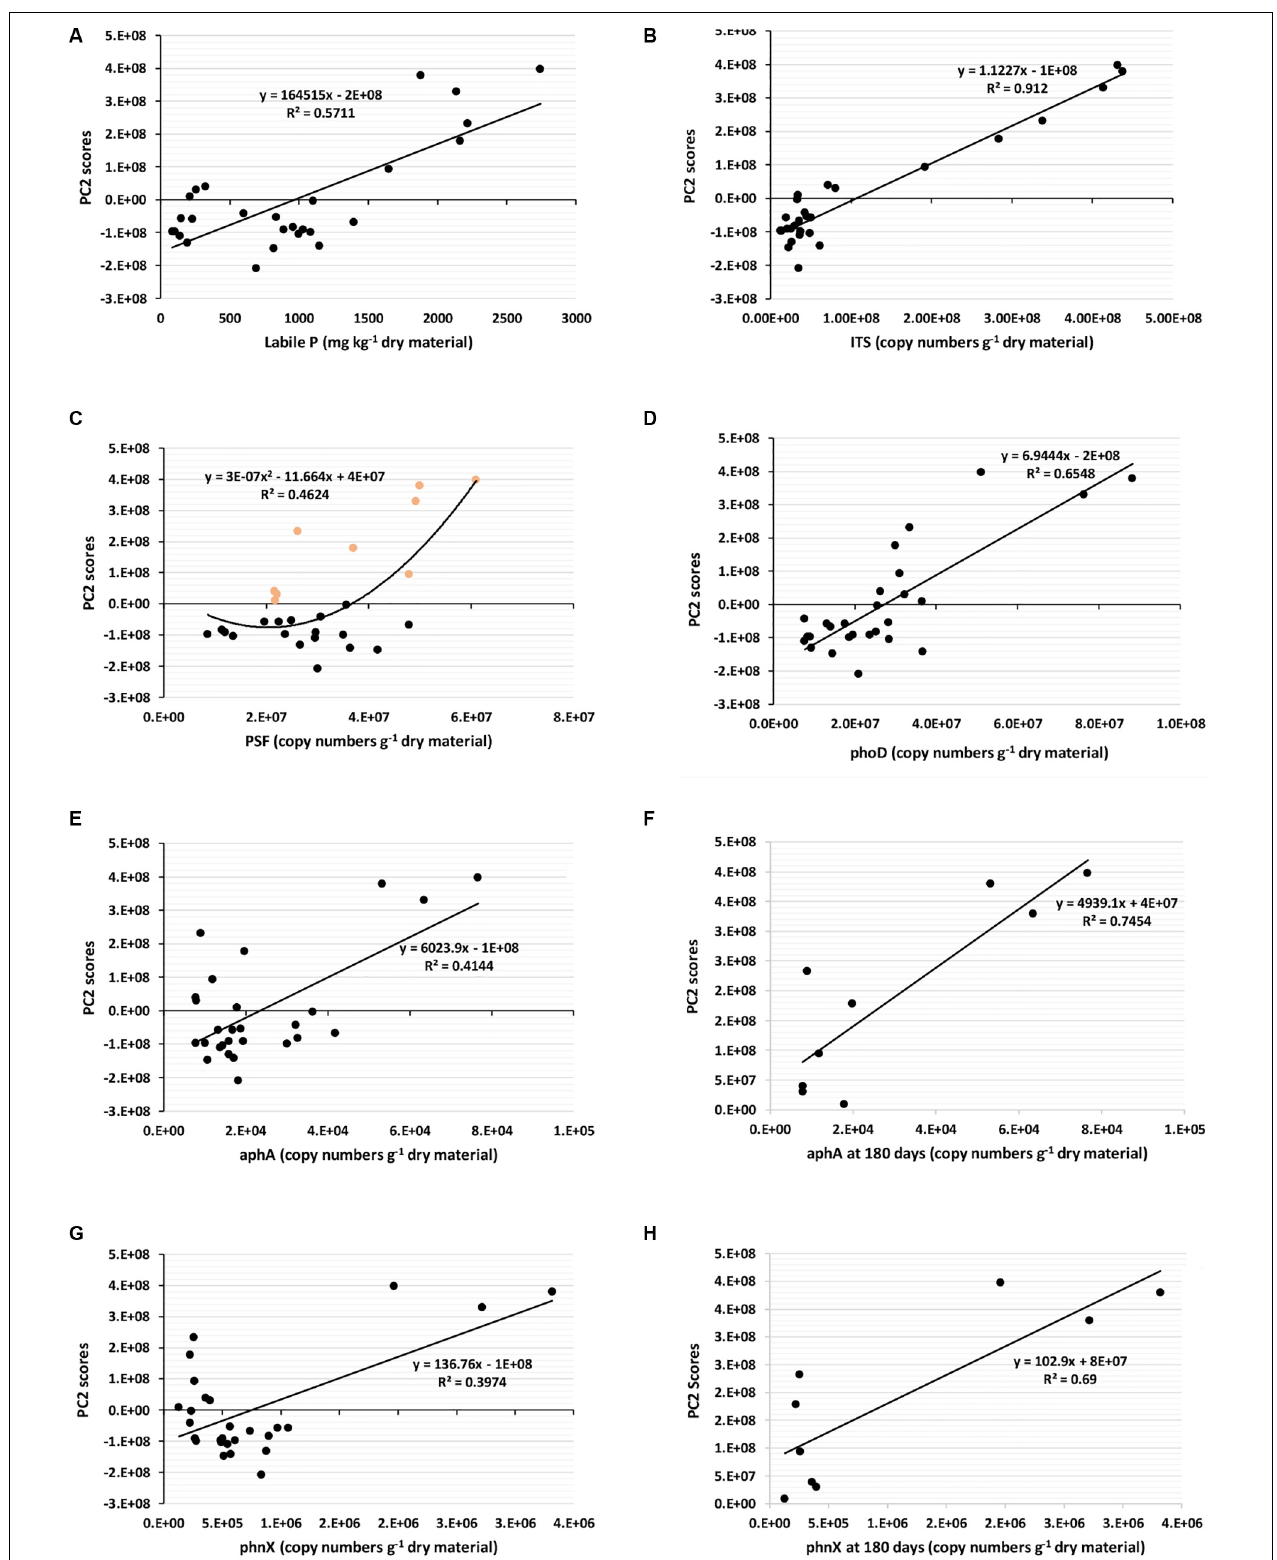
FIGURE 4 | Relationships between PC2 scores and labile P, and gene’s abundances. All compost data at 45 days, 60 days, and 180 days are considered in (A–E,G) . The orange dots at (C) are PSF abundances at 180 days. In (F,H) , gene’s abundance obtained at 180 days were selected and plotted. ITS, Total fungi; PSF, phosphate-solubilizing fungi; phoD , alkaline phosphatase; aphA , acid phosphatase; phnX , phosphonatase.